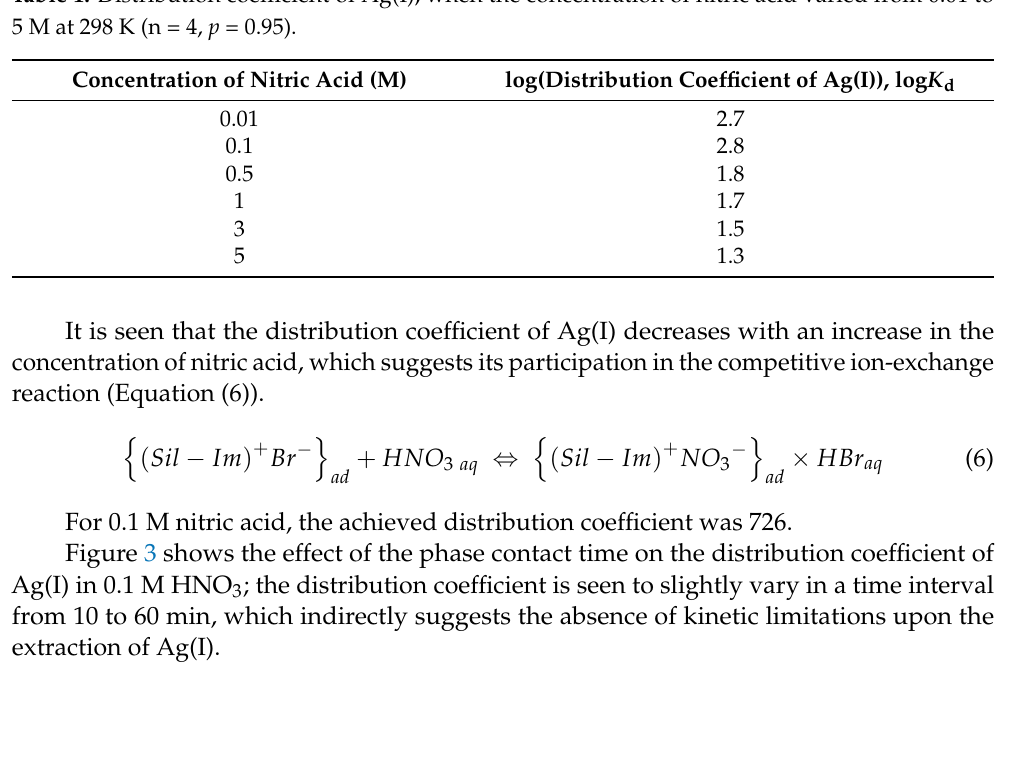
Table 1. Distribution coefficient of Ag(I), when the concentration of nitric acid varied from 0.01 to 5 M at 298 K (n = 4, p = 0.95). Concentration of Nitric Acid (M)